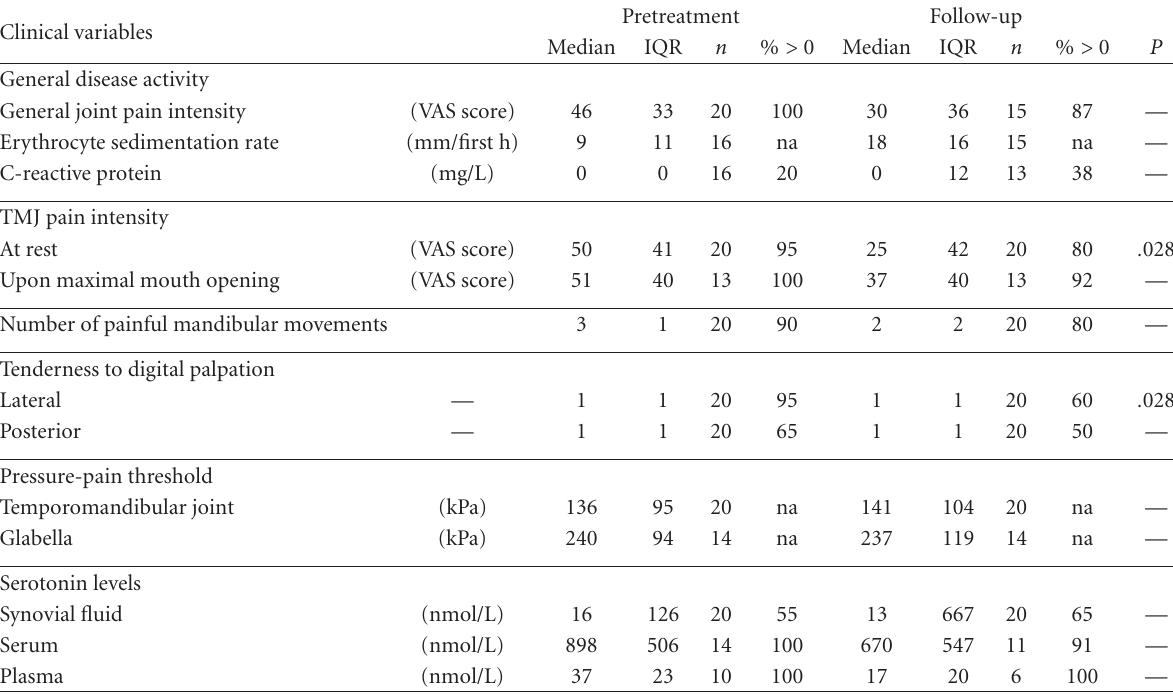
Table 2. General and local (temporomandibular joint; TMJ) disease activity before and 5 weeks after intra-articular administration of glucocorticosteroid in 20 patients with chronic inflammatory joint disease. Pain intensity was assessed with a 100 mm visual analog scale (VAS), the number of mandibular movements that provoked pain in the TMJ (maximum mouth opening, laterotrusion to both sides and protrusion) was counted for each side, tenderness to digital palpation of the lateral and posterior aspects of the TMJ on each side was recorded as one unit if the patient reported tenderness and two units if the palpation caused a pain reflex, and the pressure-pain threshold was recorded over the palpable lateral pole of the TMJ condyle and over glabella; IQR = 25th–75th percentile, n denotes number of patients, % > 0 denotes observations percent exceeding 0, and na denotes not